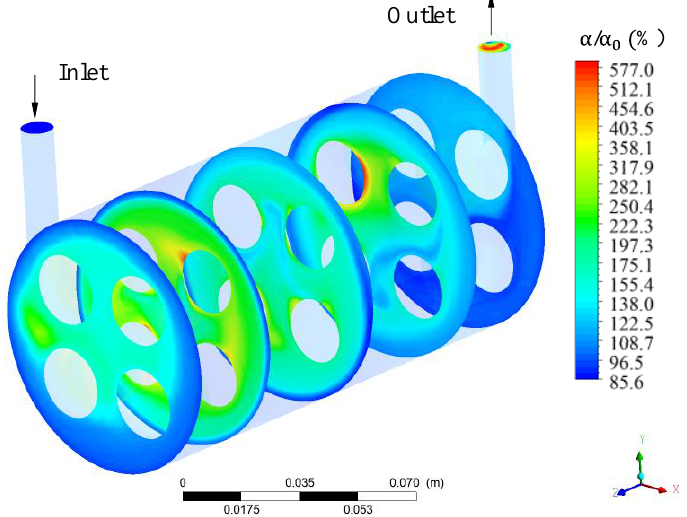
Figure 5. Relative oil volumetric fraction distribution at different plans along the hull of the filtration module during the water/oil separation process.